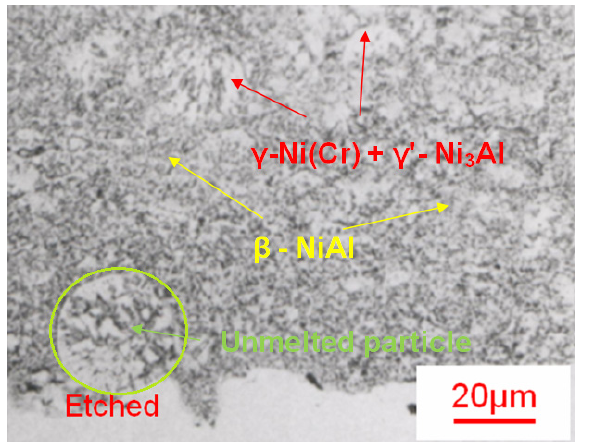
Figure 4 – (OM) Etched microstructure of the vacuum plasma sprayed Ni22Cr10Al1Y